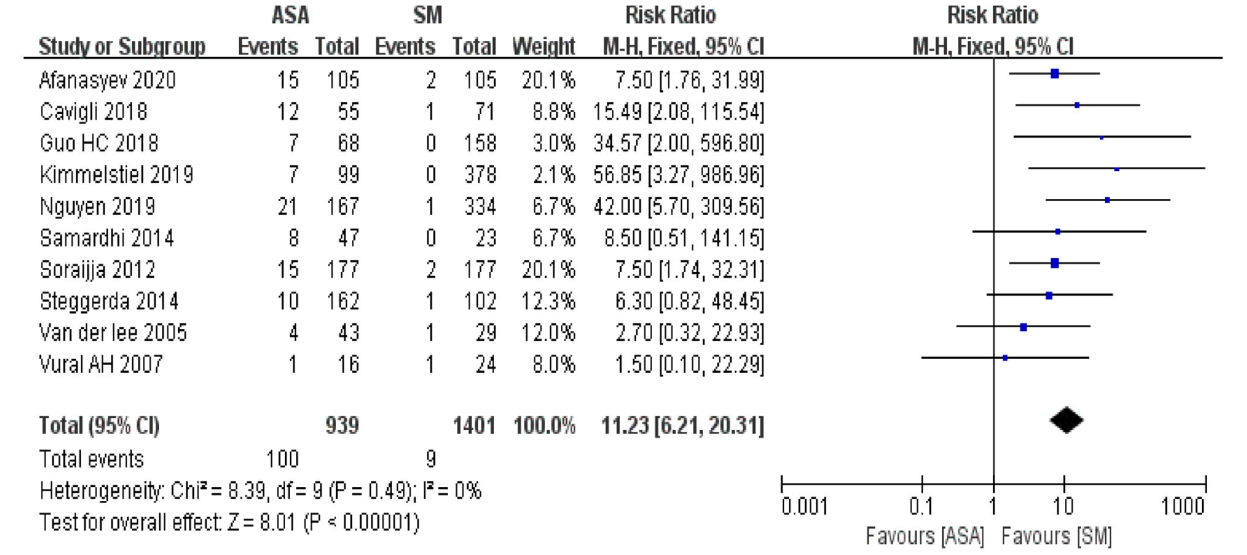
reoperation in the ASA group (10.65%) was significantly higher than that in the SM group